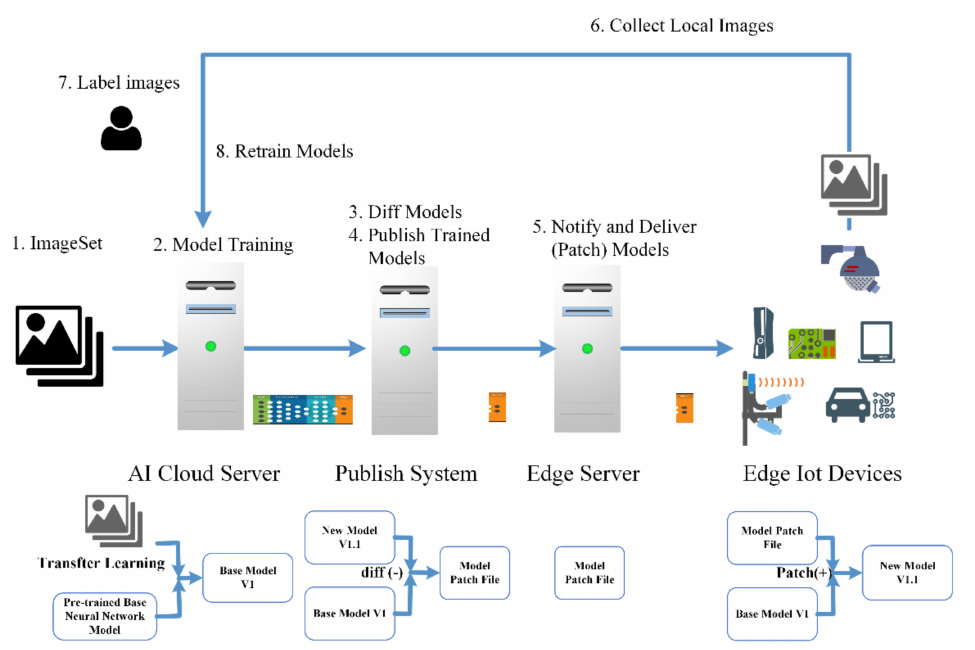
Figure 1. The proposed Cloud-Edge Smart IoT architecture and model publish system for speeding up the deployment of neural network models with transfer learning